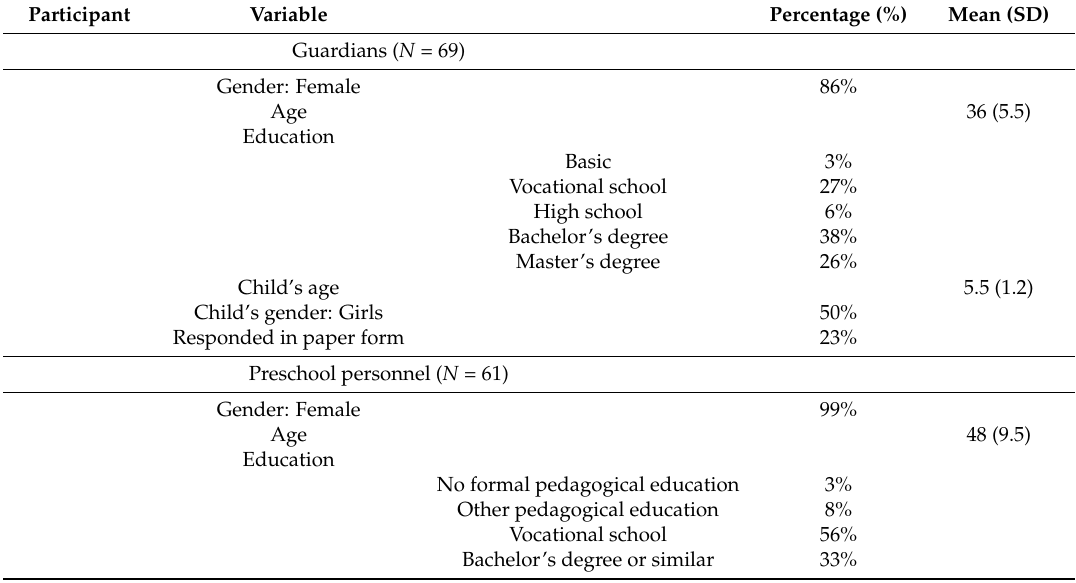
Table 1. Descriptive statistics of participants in the DAGIS reproducibility sub-study in spring 2018.